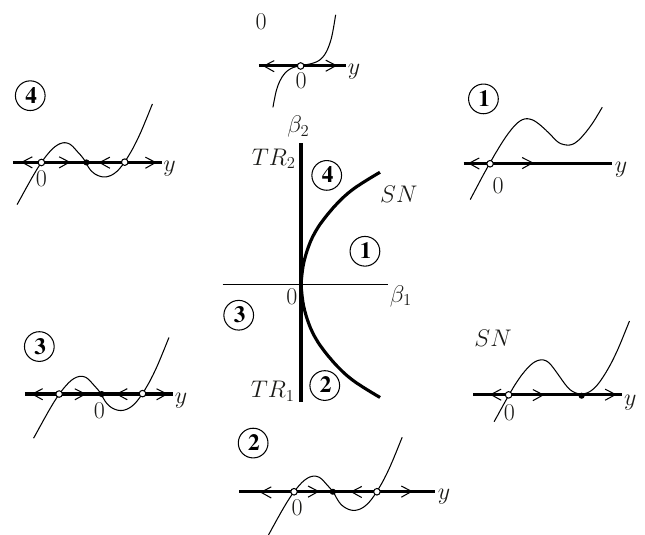
2 + y 3 . 1 y + (cid:12) 2 y